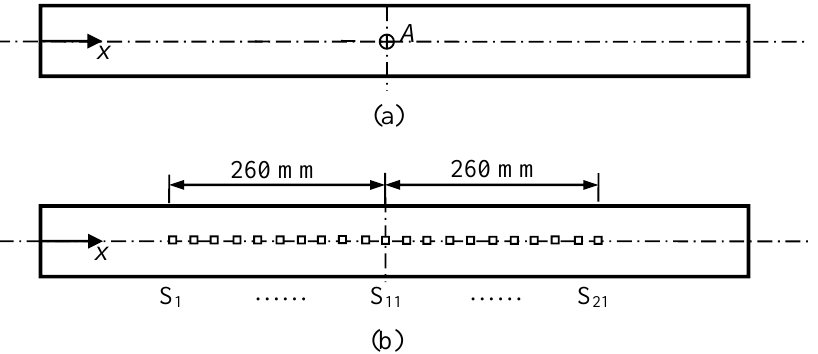
Figure 4. Illustrations for the experiments: ( a ) impact location A (top view); ( b ) distribution of strain gauges (upward view).